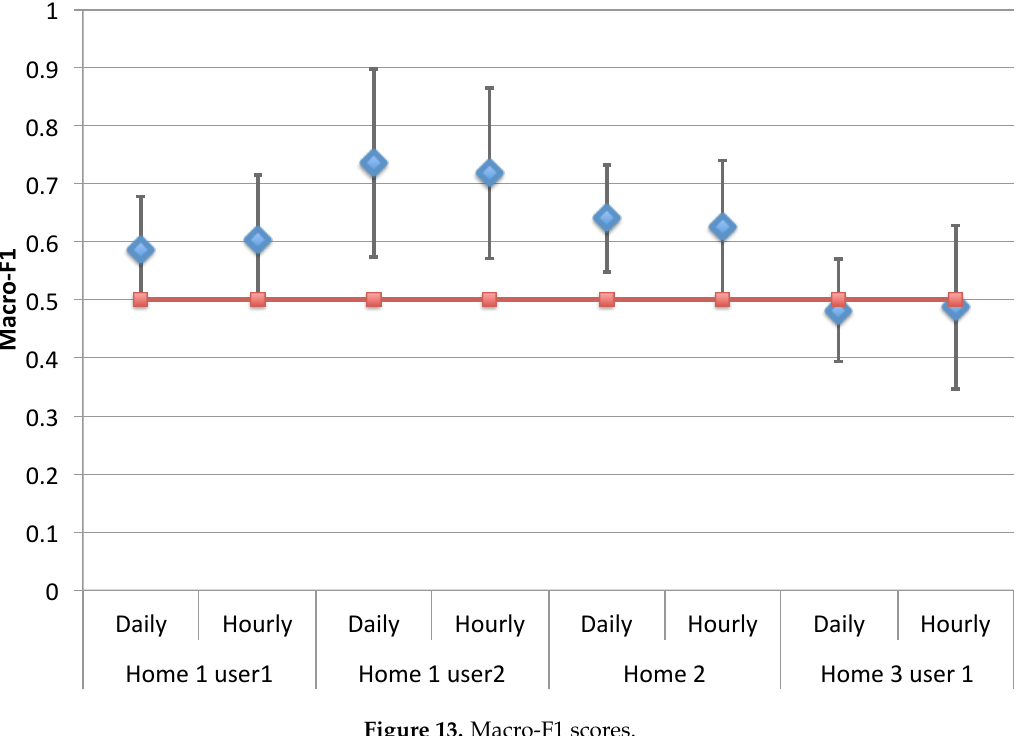
Figure 13. Macro-F1